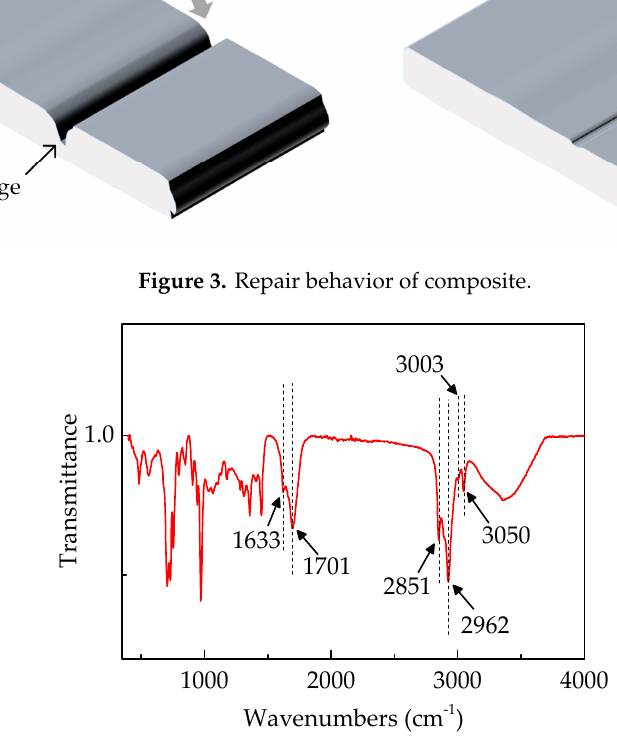
Figure 4. Infrared spectroscopy analysis of the filler in scratch.